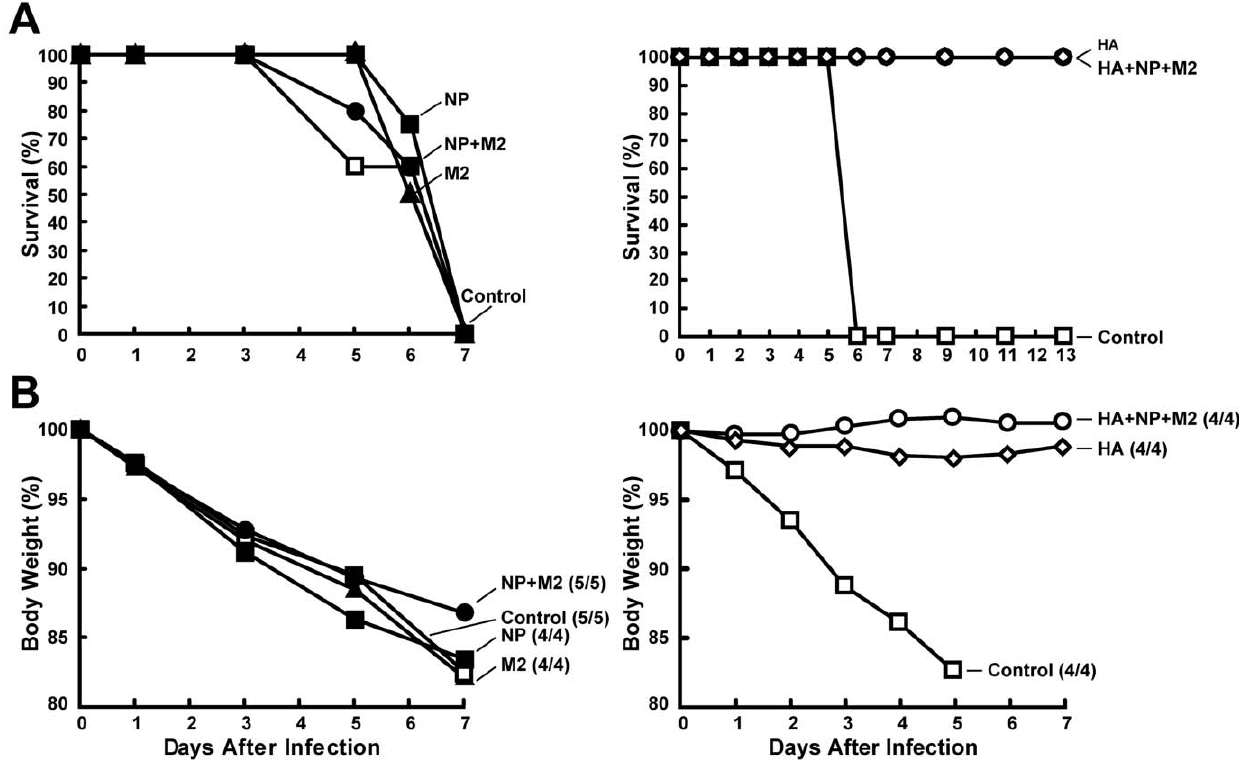
Figure 5. Protection of DNA/rAd5 vaccines encoding HA or HA + NP + M2, but not NP, NP + M2, or M2, against A/Vietnam/1203/2004 virus challenge. (A) Ferrets immunized three times with DNA followed by a single rAd5 boost were challenged under anesthesia with 10 7 EID 50 / ferret of influenza virus A/Vietnam/1203/2004. The animals were monitored 7 days for survival, shown as a percentage comparing the initial animal number to the final animal number in the same group (left panel). There was no statistical difference between the control group and groups immunized with NP, NP + M2, or M2. Both the HA and HA + NP + M2 groups showed 100% survival (right panel), whereas the vector control group showed 0% survival after the viral challenge. There was no statistically significant difference between the HA and HA + NP + M2 groups ( p =1.00), but there was a significant difference between these groups and the control ( p =0.008), by a log-rank test. (B) Body weights of the ferrets were also monitored and the total body weight of all of the surviving animals in each group was compared with the respective initial body weight (left panel). Ferrets immunized with HA and HA + NP + M2 groups showed no weight loss, while the control group ferrets showed rapid weight loss (right panel). The survival and initial animal numbers in each group on the last day of body weight data collection are indicated next to the curve labels. The survival percentage for each group was analyzed statistically by a log-rank test.